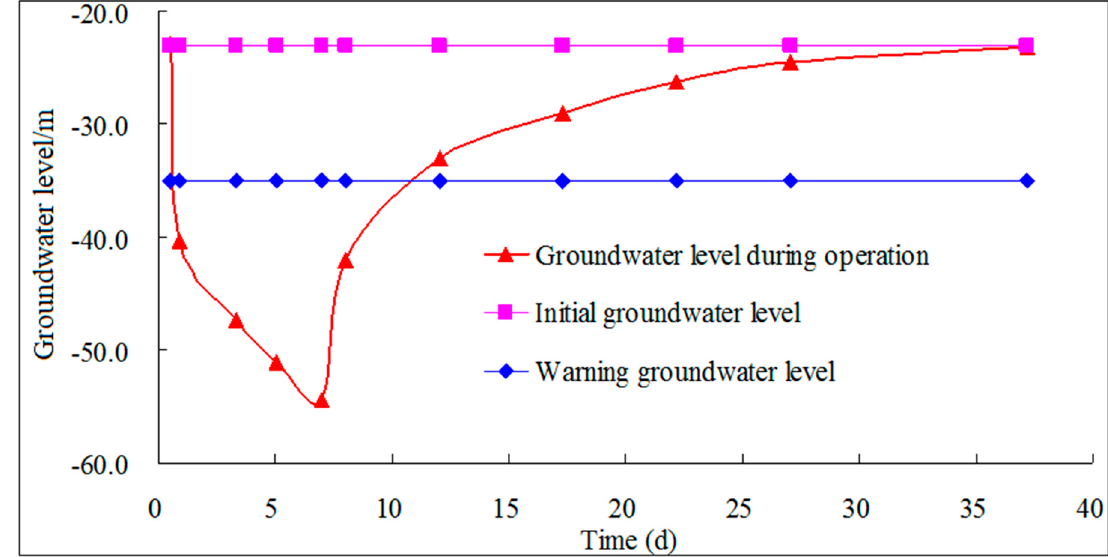
Figure 15. Change curves of groundwater level in the center of depression cone during the operation of emergency groundwater